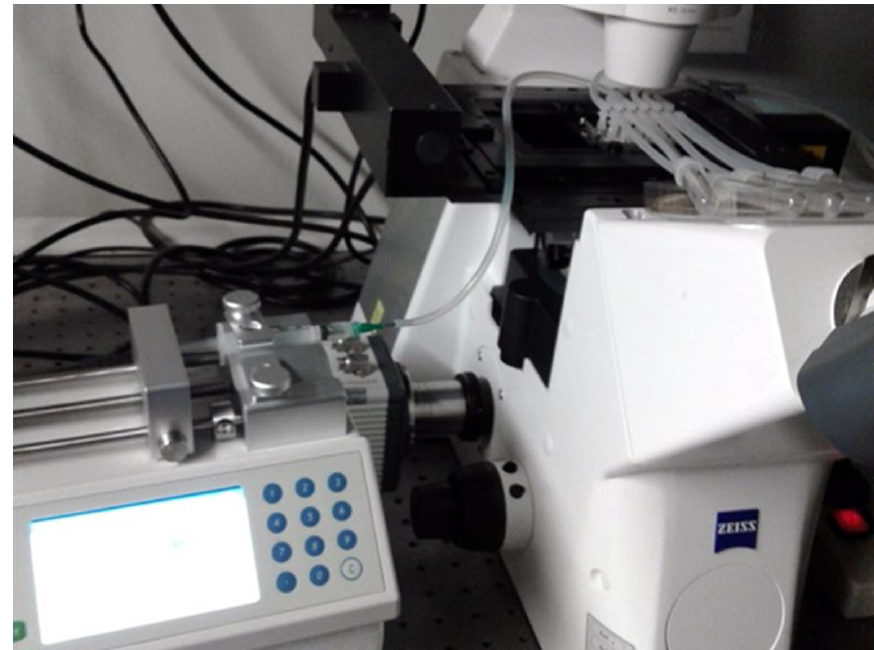
Figure 8. Linear pump (Fusion 100 Infusion Pump; Chemyx, Inc., Stafford, TX, USA) for accurate constant delivery of injected material (liquid disinfectant) with inserted disposable syringe connected to the flow cell on the stage of Zeiss Axiomat microscope through silicone tubing.